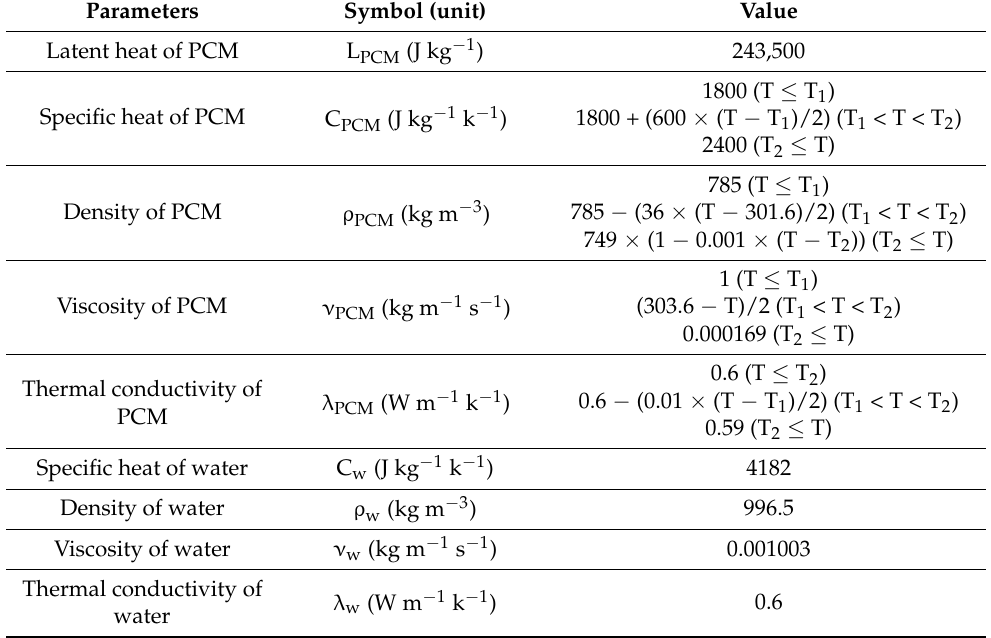
Table 1. Parameters used in simulation. (T 1 : melting temperature; T 2 : temperature of completely liquid